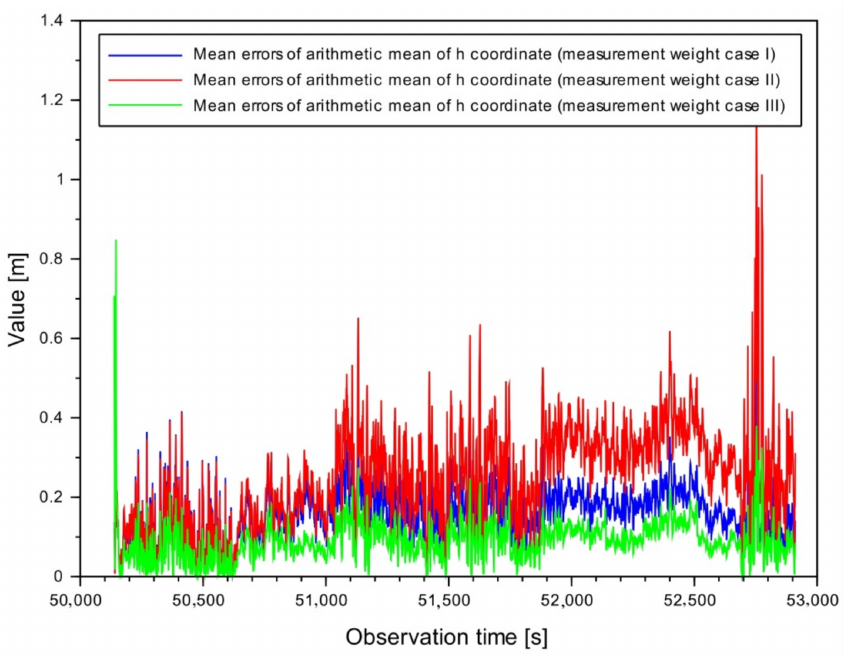
Figure 12. Mean errors of the arithmetic mean of h resultant coordinate.